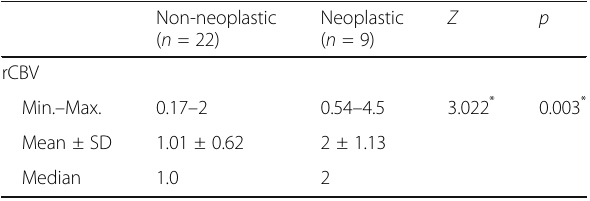
Table 3 Comparison between neoplastic and non-neoplastic groups according to rCBV compared to normal cord